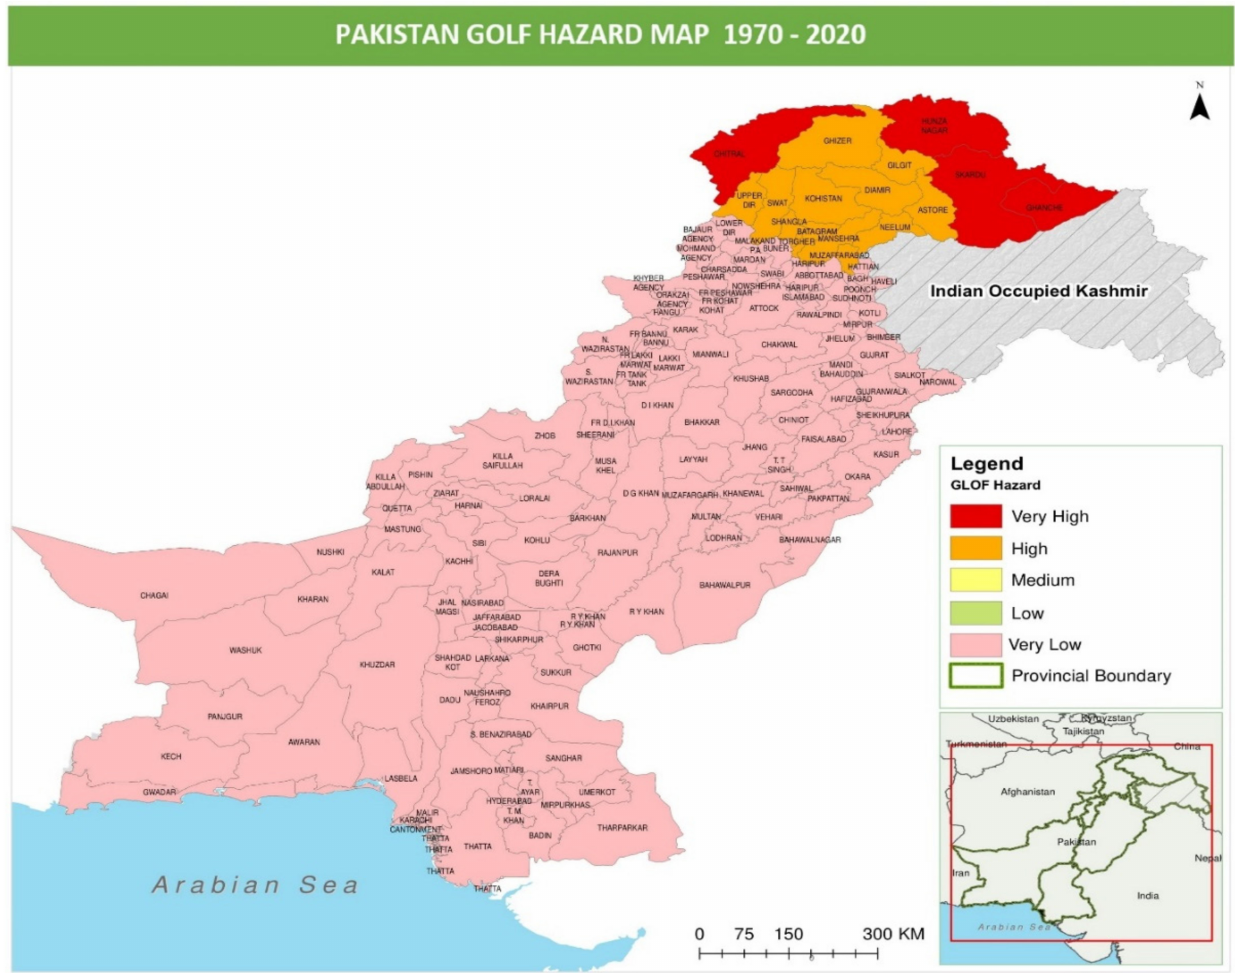
Figure 12. Pakistan GLOF Hazard Map 1970–2020 showing the intensity of GLOF at district